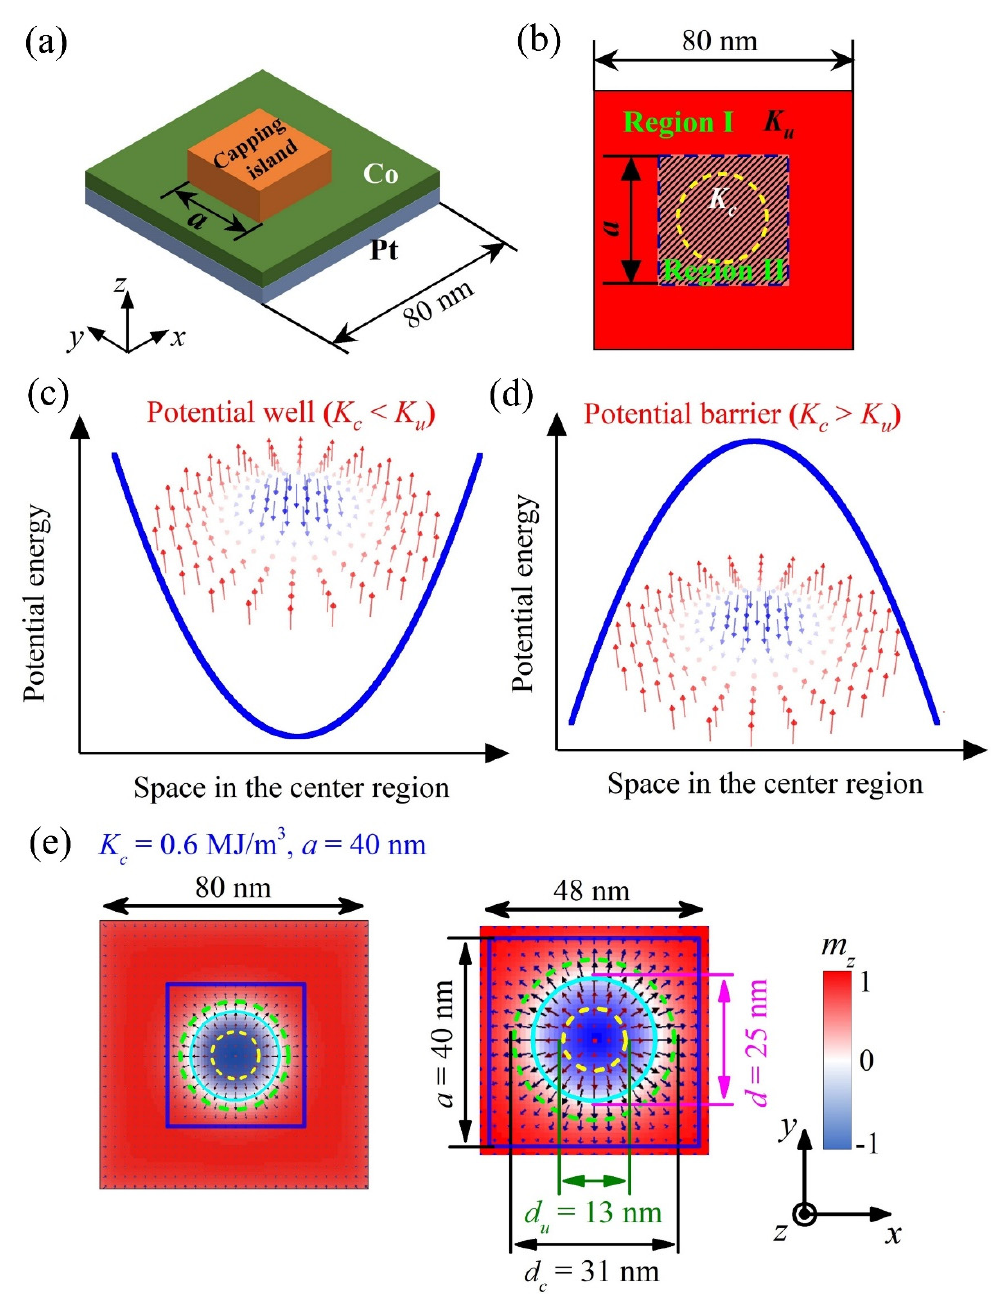
Figure 1. ( a ) Sketch of magnetic heterostructure of a square-shaped capping nano-island built on a square-shaped ultrathin Co/Pt film. ( b ) Schematic view of inhomogeneous PMA distribution on the xy -plane, in which the PMA strength ( K c ) in capping island (Region II) is variable by the capping materials, and the PMA strength ( K u ) in the outer ring of the Co/Pt film (Region I) is fixed with K u = 0.8 MJ/m 3 . The inserted yellow dashed circle with diameter of 30 nm represents spin-polarized current injection ( p = 0.4) in the central region. ( c , d ) The nucleation of skyrmion in panel ( c ) potential well for K c < K u or ( d ) potential barrier for K c > K u . ( e ) The isolated skyrmion with diameter d under the inhomogeneous PMA distribution of K c = 0.6 MJ/m 3 and a = 40 nm, with the enlarge image of the skyrmion structure shown at the right panel. Insert shows the color scale for the z -component of the magnetization configurations m z . The capping region is enclosed by blue lines. The diameters d , d c and d u are marked by the cyan solid, green dashed, and yellow dashed circles, respectively.